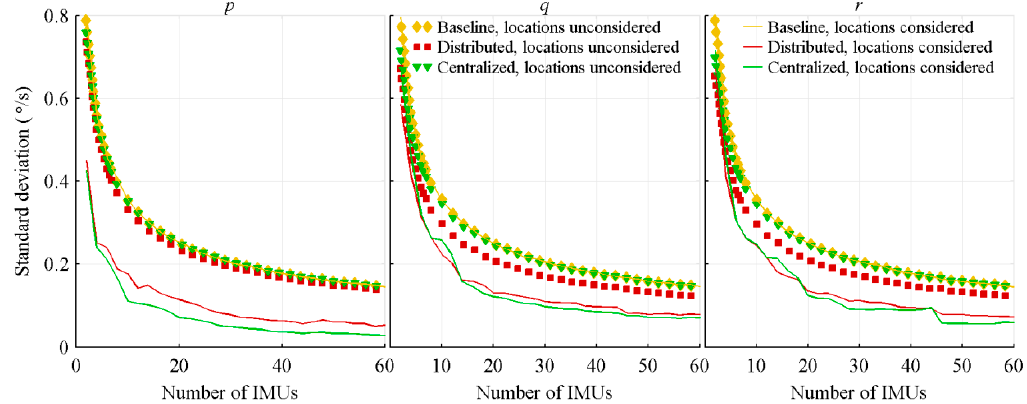
Figure 5. Standard deviation of the attitude rate estimation errors, with respect to the number of IMUs.